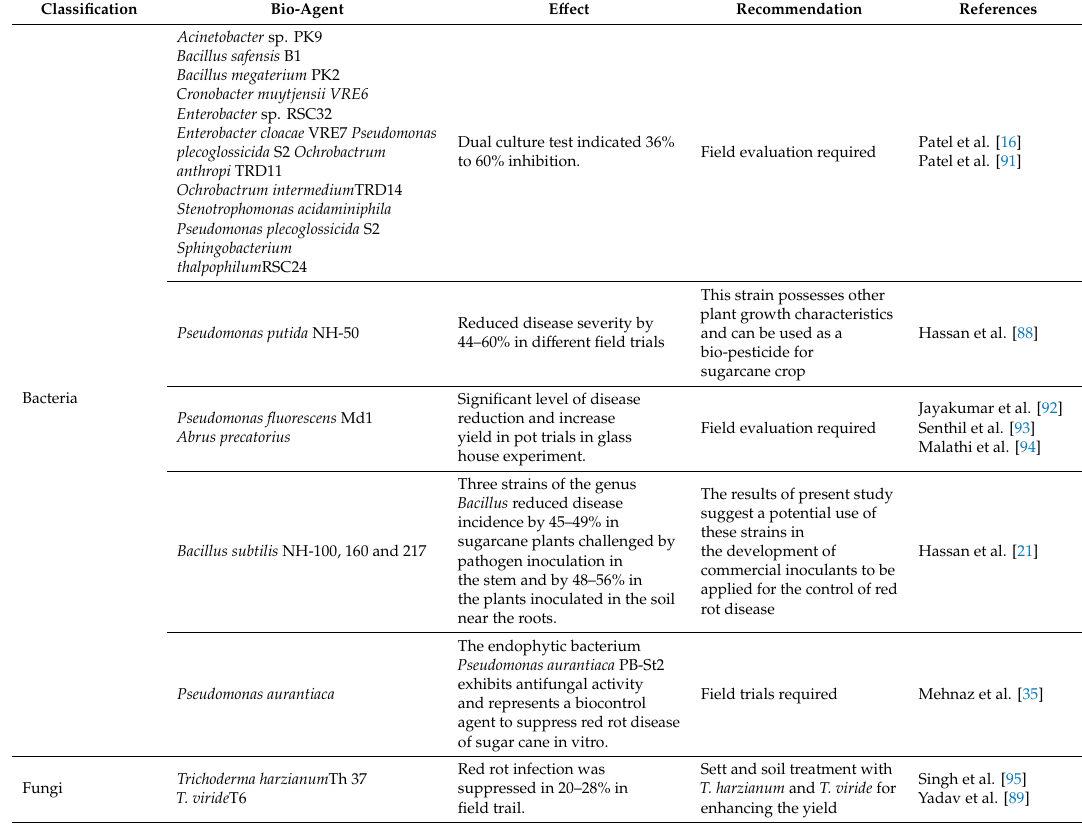
Table 2. Potential biocontrol agents and their e ff ects on red rot management in vitro or field